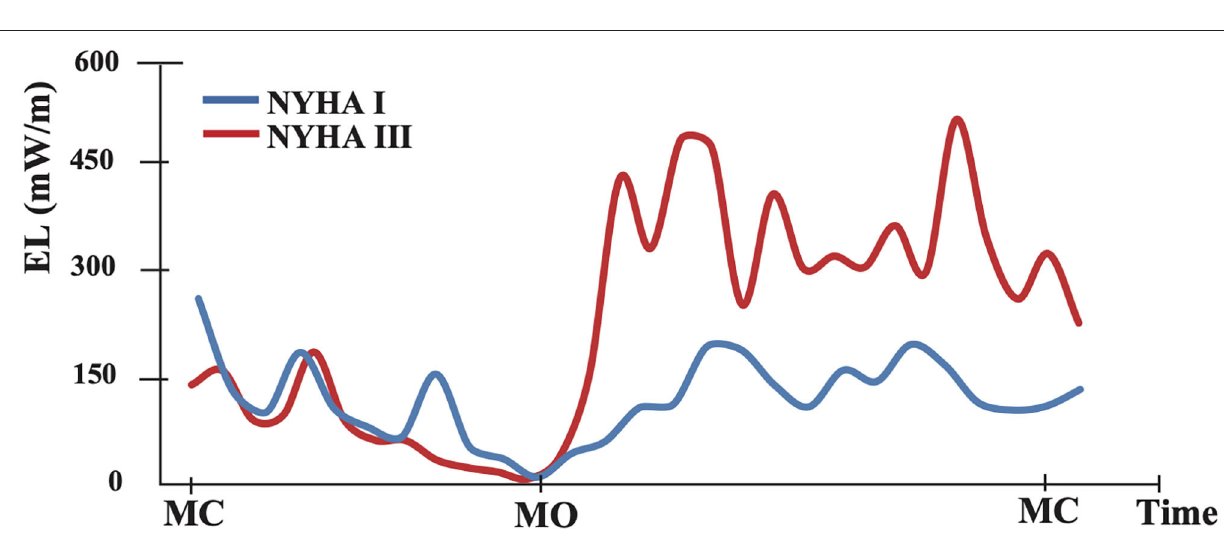
FIGURE 2 | The graph shows an example of intraventricular flow energy loss distribution during one cardiac cycle. The blue curve represents the asymptomatic case (NYHA I) and red represents the symptomatic case (NYHA III). MC, mitral valve closing; MO, mitral valve